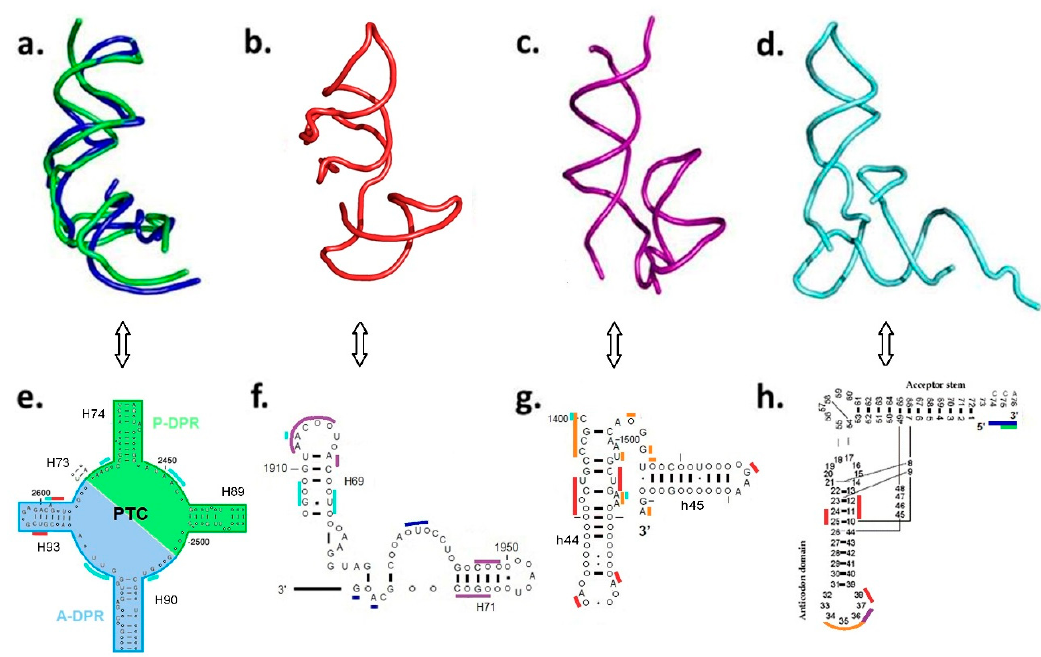
Figure 3. Building blocks of the initial translation system model. ( a ) Overlap of the symmetry-related A- and P-DPR elements assembling the non-coded proto-ribosome ( b ) the H69–71 bridging element, ( c ) the h44–45 proto-SSU, ( d ) tRNA, ( e – h ) the secondary schemes of the four building blocks. Highly conserved nucleotides (materials and methods) are presented by capital letters and nucleotides involved in interactions among the different types of building-block are marked by a contour line having the color of the interacting block: A-DPR (blue), P-DPR (green), H69–71 bridging element (red), h44–45 proto-SSU (purple), tRNAs (cyan), mRNA (orange). The same color code is maintained in Figures